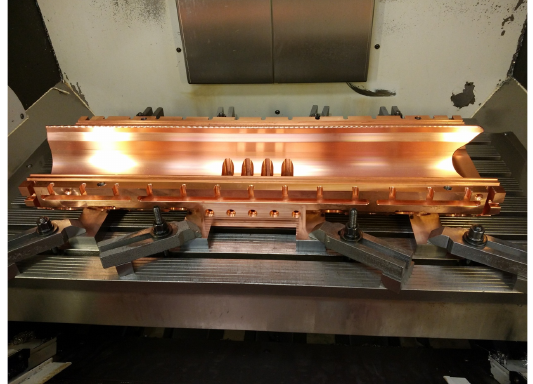
Figure 22. A major vane of the RFQ after fine machining in the milling